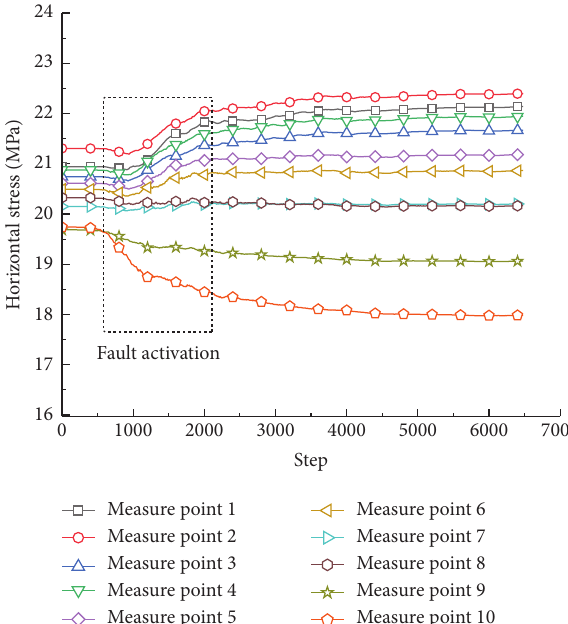
Figure 10: Horizontal stress of fault measuring points.